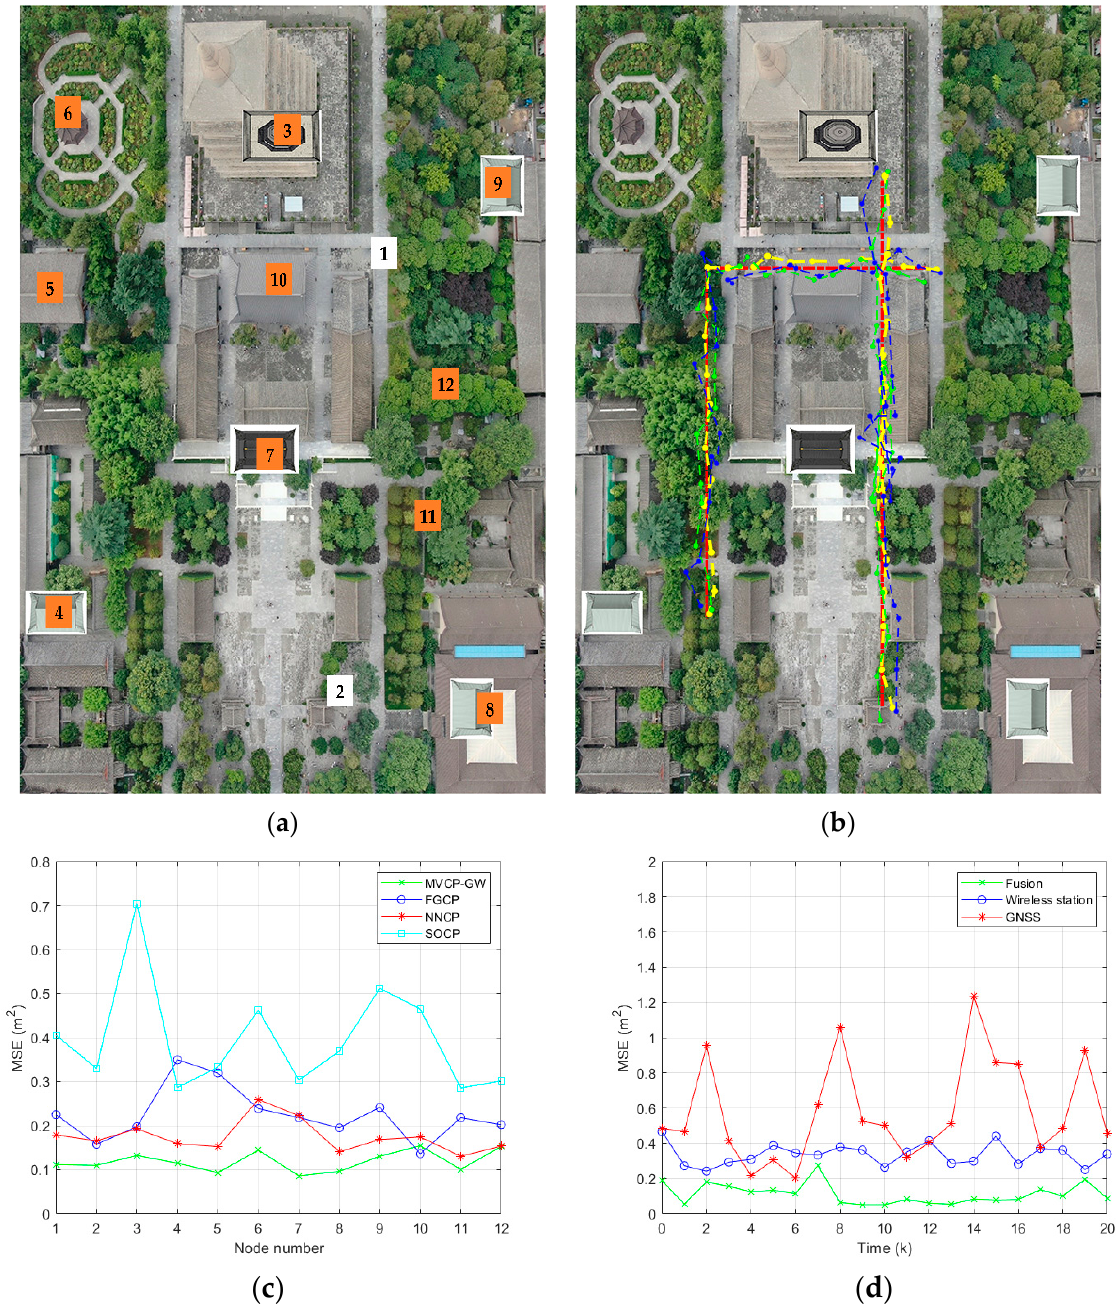
Figure 10. Testing results of the physical verification platform: ( a ) static positioning results of 20 nodes; ( b ) dynamic positioning results of node 1 and node 2; ( c ) static positioning errors of 20 nodes; ( d ) dynamic positioning error of node 1.